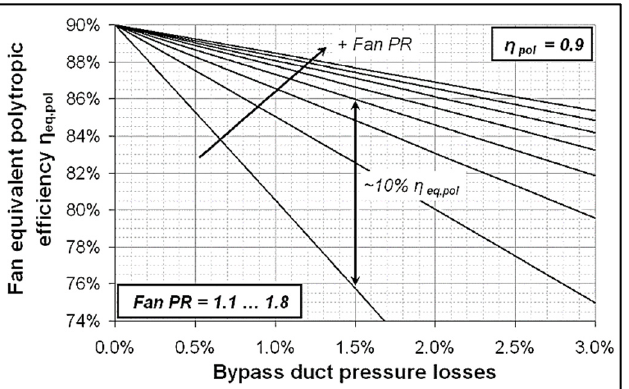
Figure 13. Non-dimensional velocity profiles at the exit of diffuser 1 corresponding to a range of non-uniformities (1 − γ ).